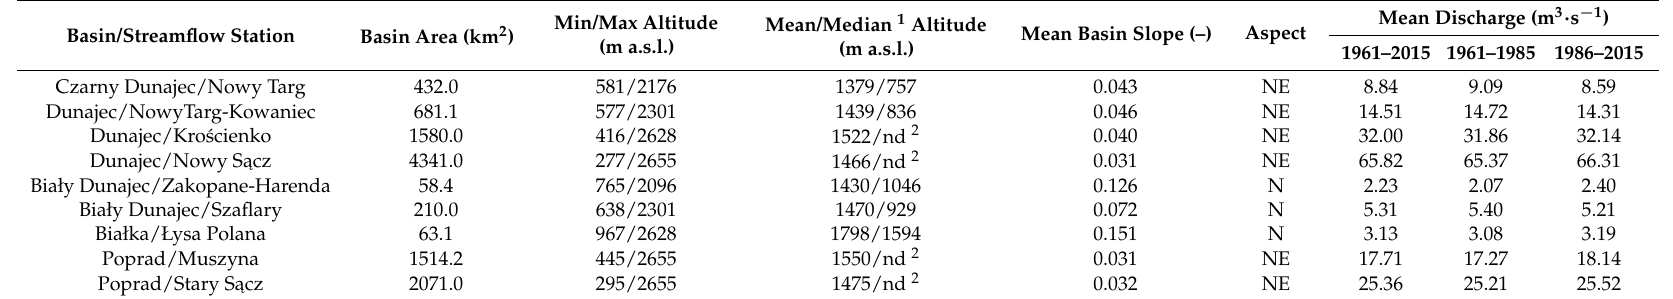
Table 2. Physiographic characteristics of the studied river catchments